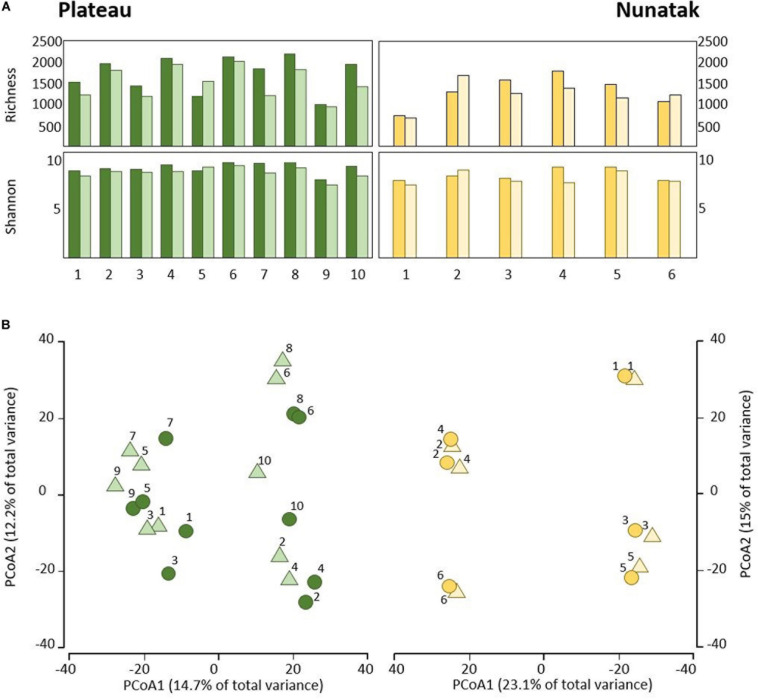
(A) Alpha diversity indices of the bacterial community of top-stratum soils (0–2 cm; dark colored plots) and deeper-stratum soils (5–10 cm; light colored plots) from Plateau and Nunatak. (B) Principal coordinate analysis (PCoA) of the bacterial community composition of top-stratum soils (0–2 cm; dark colored dots) and deeper-stratum soils (5–10 cm; light colored triangles) from Plateau and Nunatak. The principal coordinate analysis are based on Bray-Curtis dissimilarity matrices between the microbiome profiles. Distances between symbols on the ordination plot reflect relative dissimilarities in community structures. The variation in microbial community structures explained by each PCoA axis is given in parentheses.